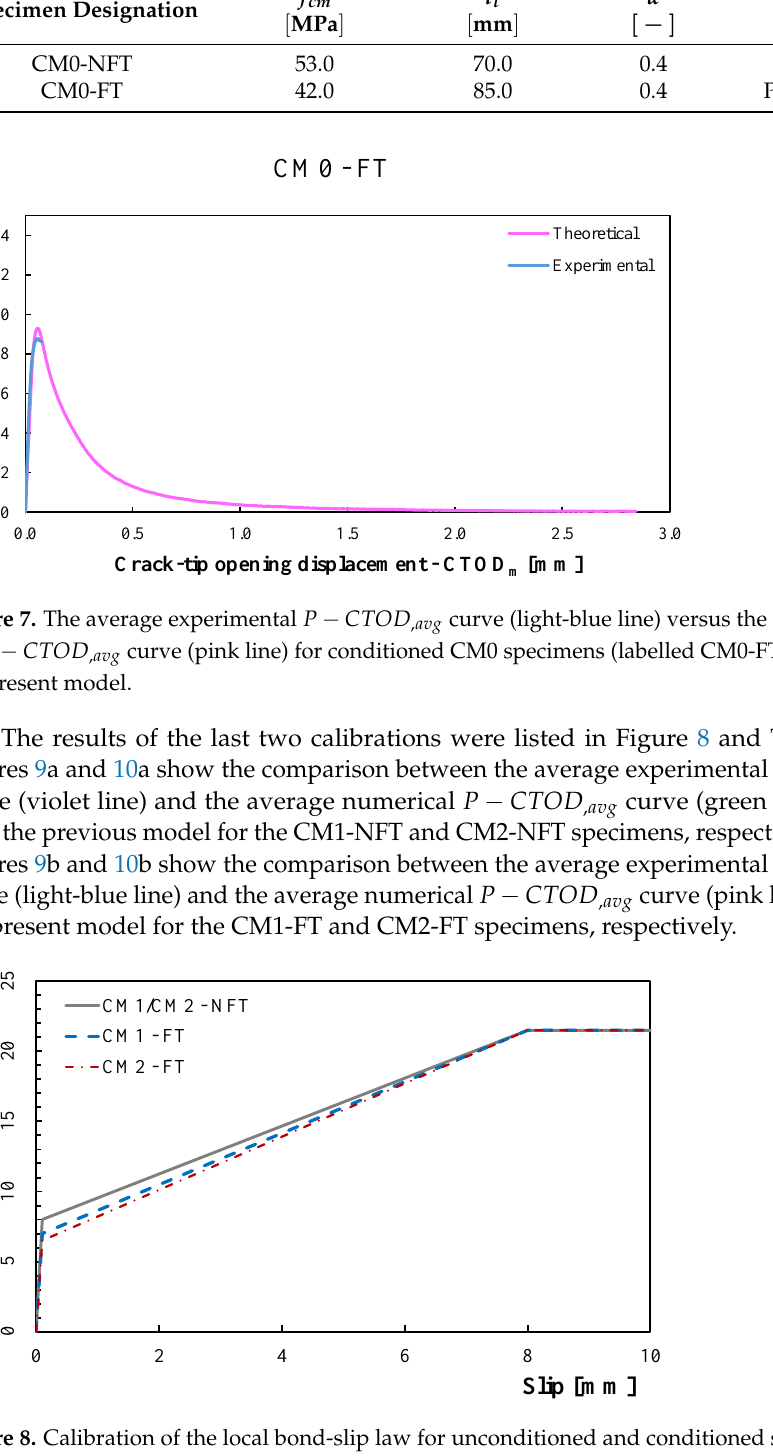
Figure 8. Calibration of the local bond-slip law for unconditioned and conditioned specimens. Table 4. Calibration of the six parameters in the local bond-slip law for unconditioned CM1 and CM2 specimens (labelled, respectively, CM1-NFT and CM2-NFT) as well as for conditioned CM1 and CM2 specimens (labelled, respectively, CM1-FT and CM2-FT) used in the previous model of Ref. Error! Reference source not found. and in the last one, respectively. Series